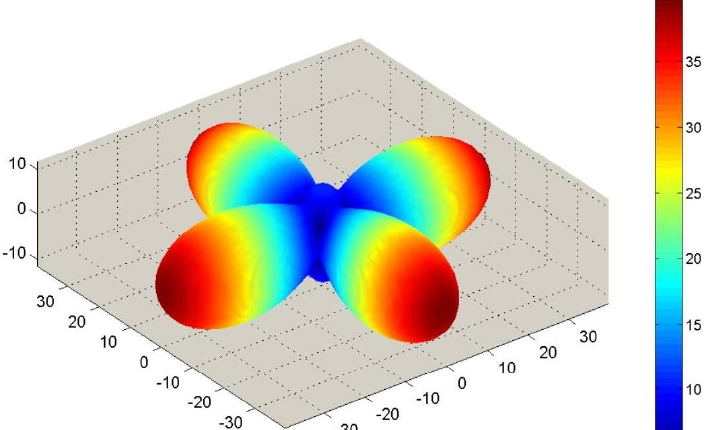
Figure 5. Longitudinal surface representation, s D ( h ) (10 −12 m 2 /N), for the compliance of